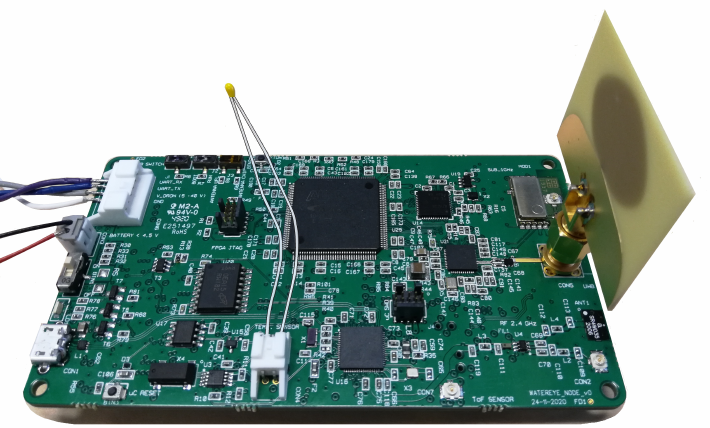
Figure 4. Sensor Node